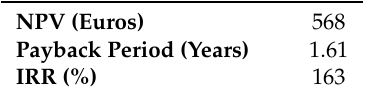
Table 10. Intensive Collector’s Indicators